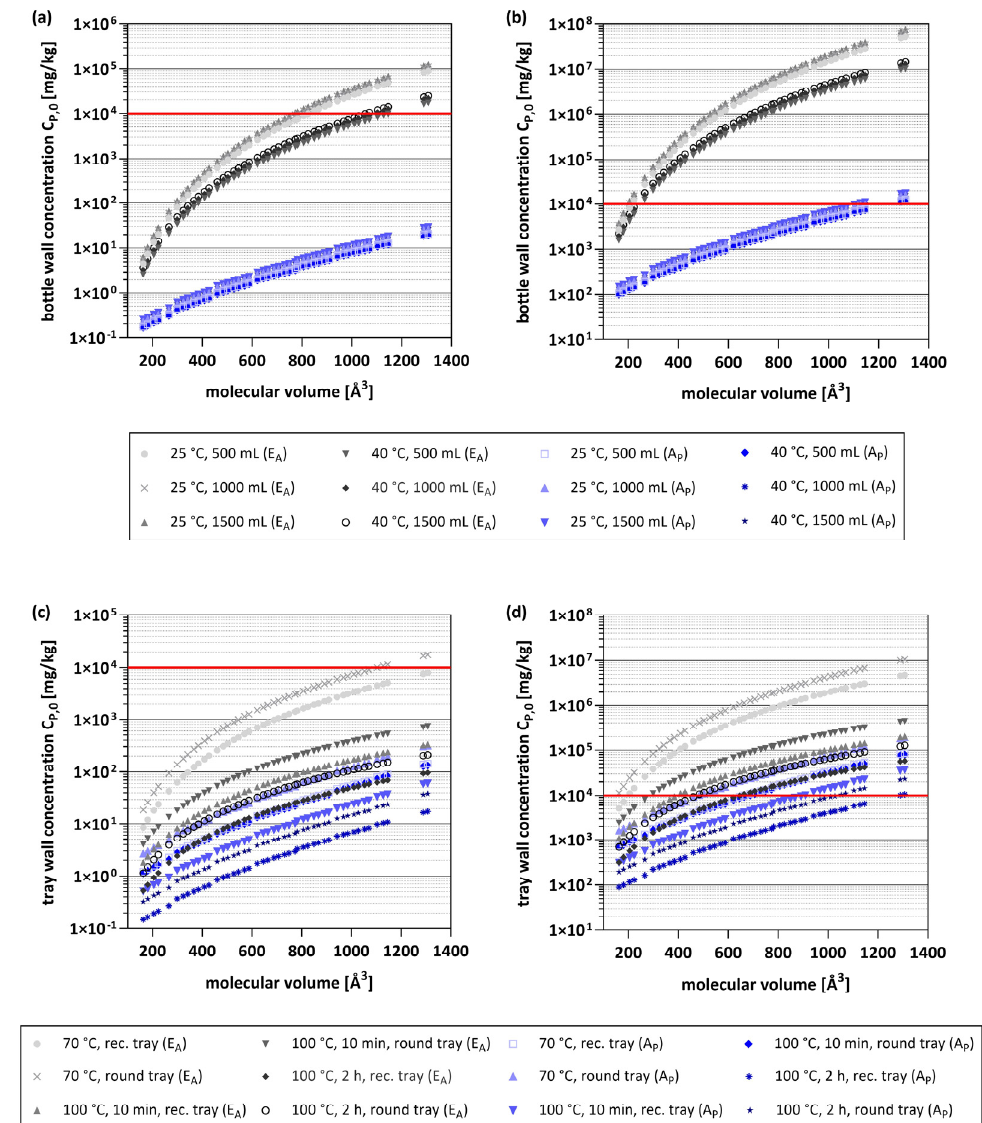
Figure 3. Maximum bottle and tray wall concentrations (C P,0 ) of all oligomers corresponding to a migration of 90 µg/kg or 0.15 µg/kg, calculated for the E A -based model (grey) and the A P model (blue). (a) C P,0 concentrations for 500, 1000, and 1500 mL bottle at 25 °C for 365 d and 40 °C for 60 d corresponding to a migration of 0.15 µg/kg. (b) C P,0 concentrations for 500, 1000, and 1500 mL bottles at 25 °C for 365 d and 40 °C for 60 d corresponding to a migration of 90 µg/kg. (c) C P,0 concentrations for rectangular (rec.) and round trays at 70 °C for 30 min and 100 °C for 10 min or 2 h corresponding to a migration of 0.15 µg/kg. (d) C P,0 concentrations for rectangular (rec.) and round trays at 70 °C for 30 min and 100 °C for 10 min and 2 h corresponding to a migration of 90 µg/kg. Red line indicates a C P,0 concentration of 1% (w/w).